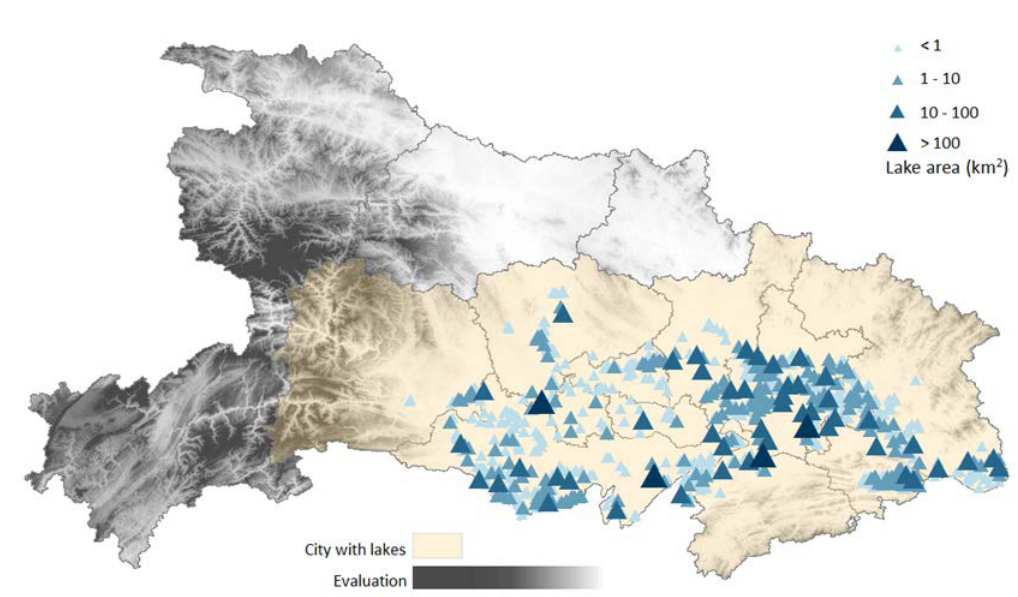
Figure 1. Distribution of the Jianghan Lake Group in 2014